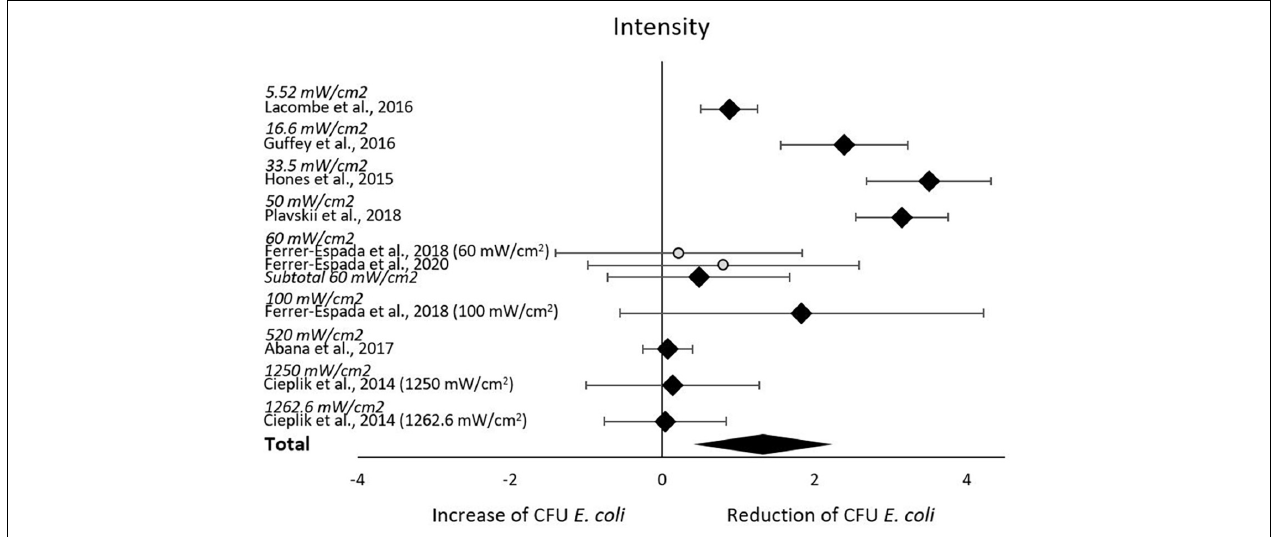
FIGURE 4 | Forest plot of reduction of E. coli post blue light exposure by